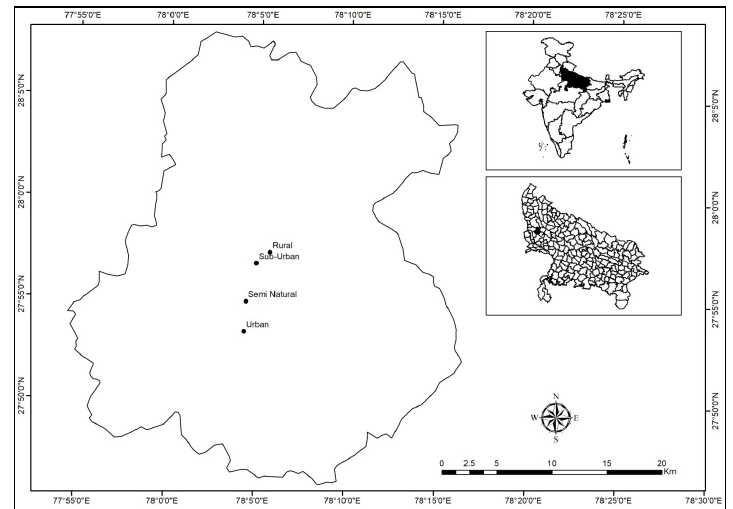
Fig. 1. Bird sampling sites in Aligarh district, Uttar Pradesh, India